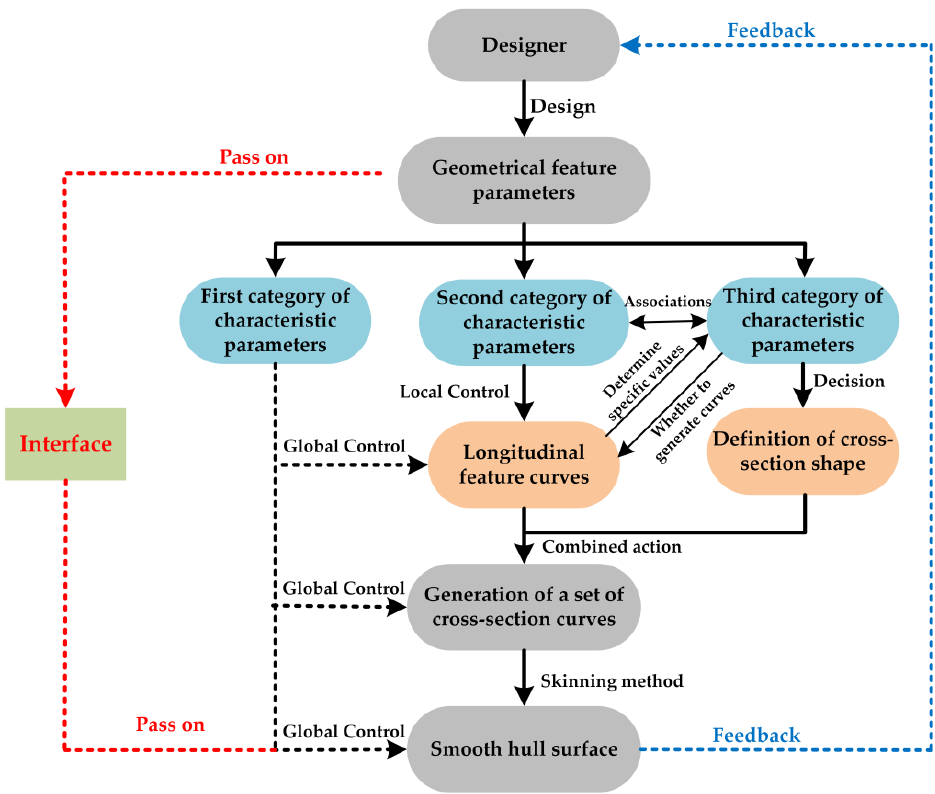
Figure 3. Parametric ship design process.